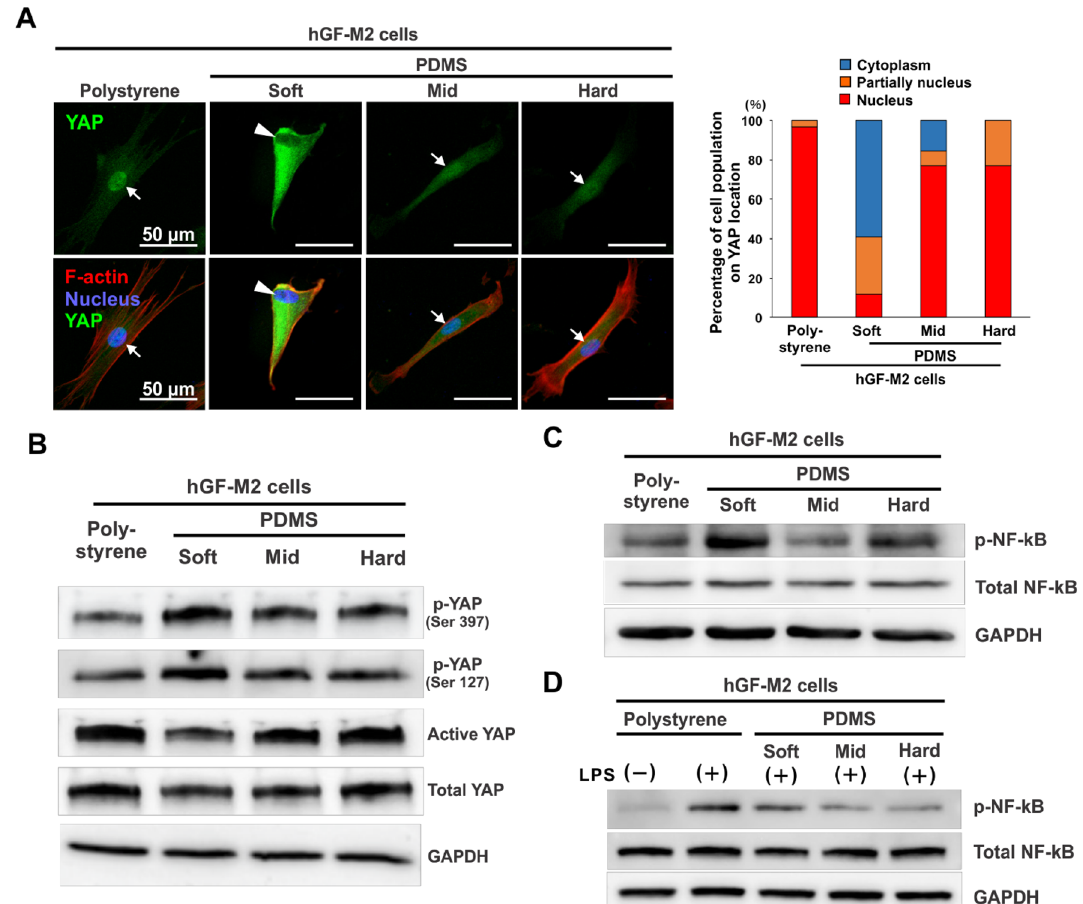
Figure 4. Effects of substrate stiffness on the activation of mechanotransduction and proinflammatory signaling pathways in hGFs. ( A ) Immunofluorescence confocal laser microscopic images of YAP (green), F -actin (red), and nucleus (blue) with a cumulative bar chart for the percentage of cell populations on YAP localization and ( B-D ) Western blotting-based expression analysis of p-YAP (Ser397), p-YAP (Ser127), active YAP, total YAP, p-NF-kB, and total NF-kB in hGF-M2 cells cultured on the 0.1wt% collagen-coated polystyrene culture plate and soft, mid, and hard PDMS for 12 h with or without co-incubation with 1,000 ng/mL of LPS. hGFs human gingival fibroblasts, PDMS polydimethylsiloxane, LPS lipopolysaccharide, YAP yes-associated protein, p-YAP phosphorylated Yes-associated protein, NF-kB nuclear factor kappa-light-chain-enhancer of activated B, p-NF-kB phosphorylated nuclear factor kappa-light-chain-enhancer of activated B, GAPDH glyceraldehyde-3-phosphate